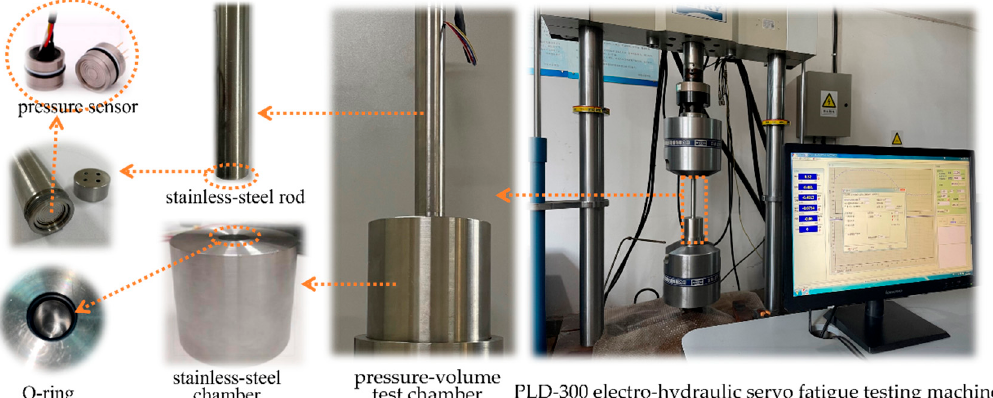
Figure 2. Pressure–volume test bench for nanofluidic stuffing.